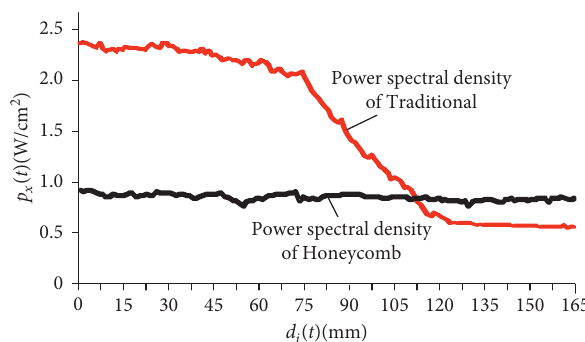
Figure 6: Power spectral density simulations of different vibration networks.